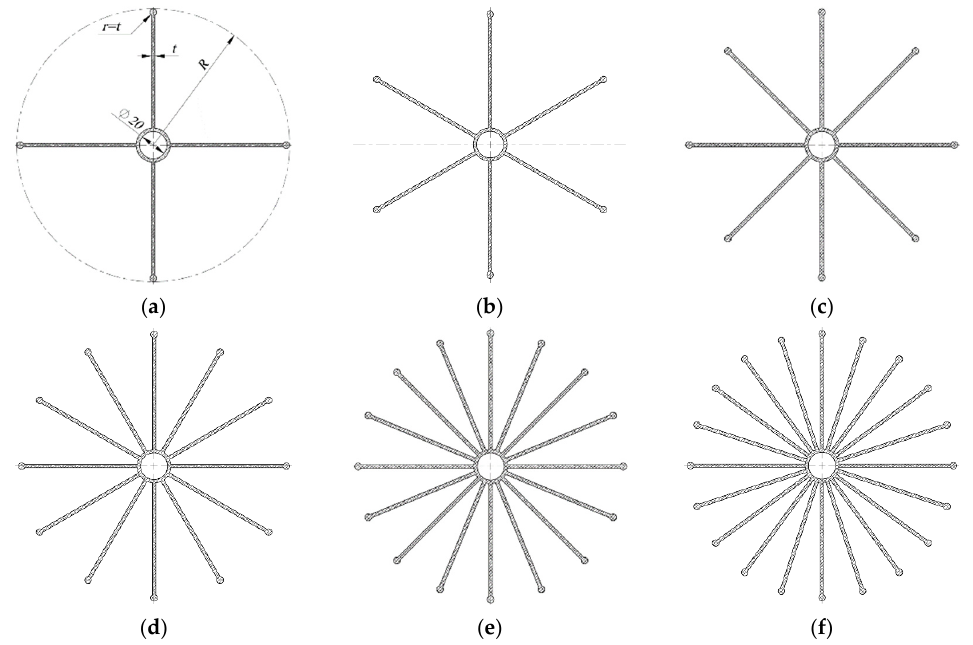
Figure 1. Cross-sections of tubes ( t = 2.5 mm, R = 100 mm) with: ( a ) 4 fins; ( b ) 6 fins; ( c ) 8 fins; ( d ) 12 fins; ( e ) 16 fins; ( f ) 20 fins.